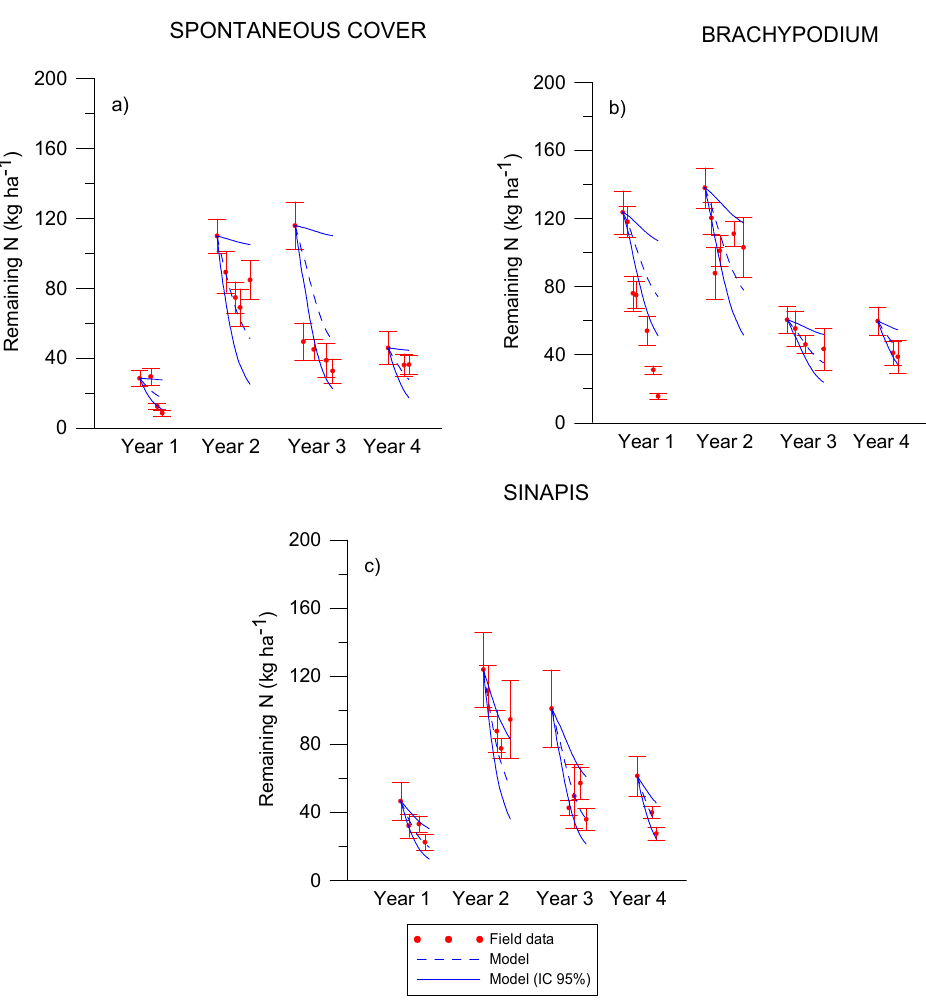
Figure 3. Measured and modelled N amounts during the four decomposition cycles for spontaneous cover ( a ), Brachypodium ( b ) and Sinapis ( c ).